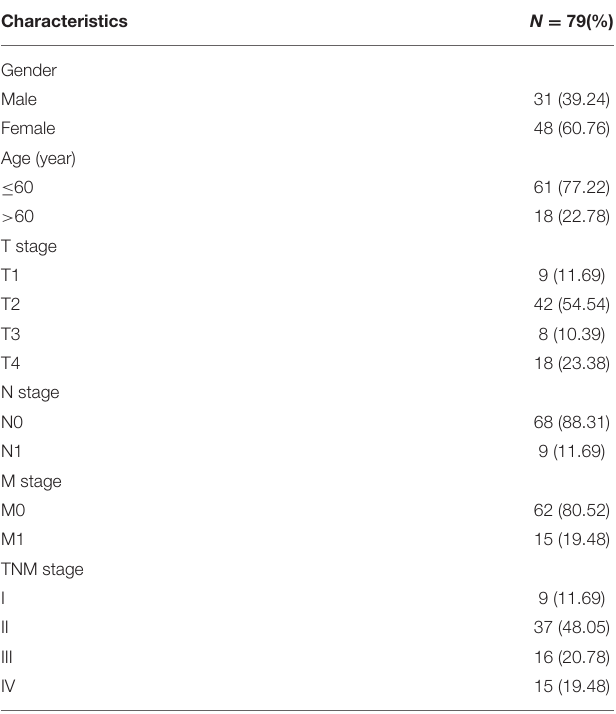
TABLE 1 | The clinicopathologic features of 79 patients in the TCGA-ACC cohort.